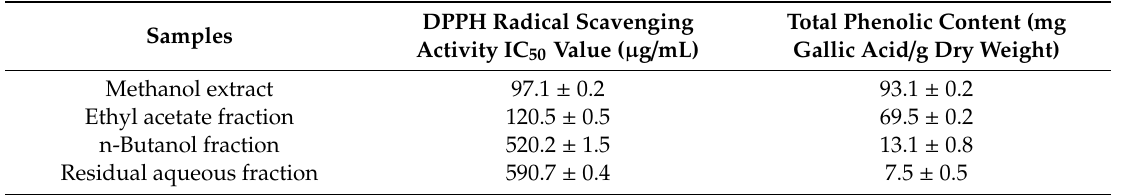
Table 4. DPPH (2,2-Diphenyl-1-Picrylhydrazyl) radical scavenging activity and total phenolic content of methanolic extract and fractions from S. formosana